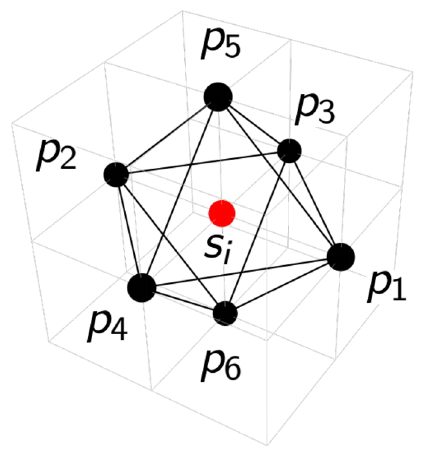
Figure 33 . Toric diagram for Model 12.